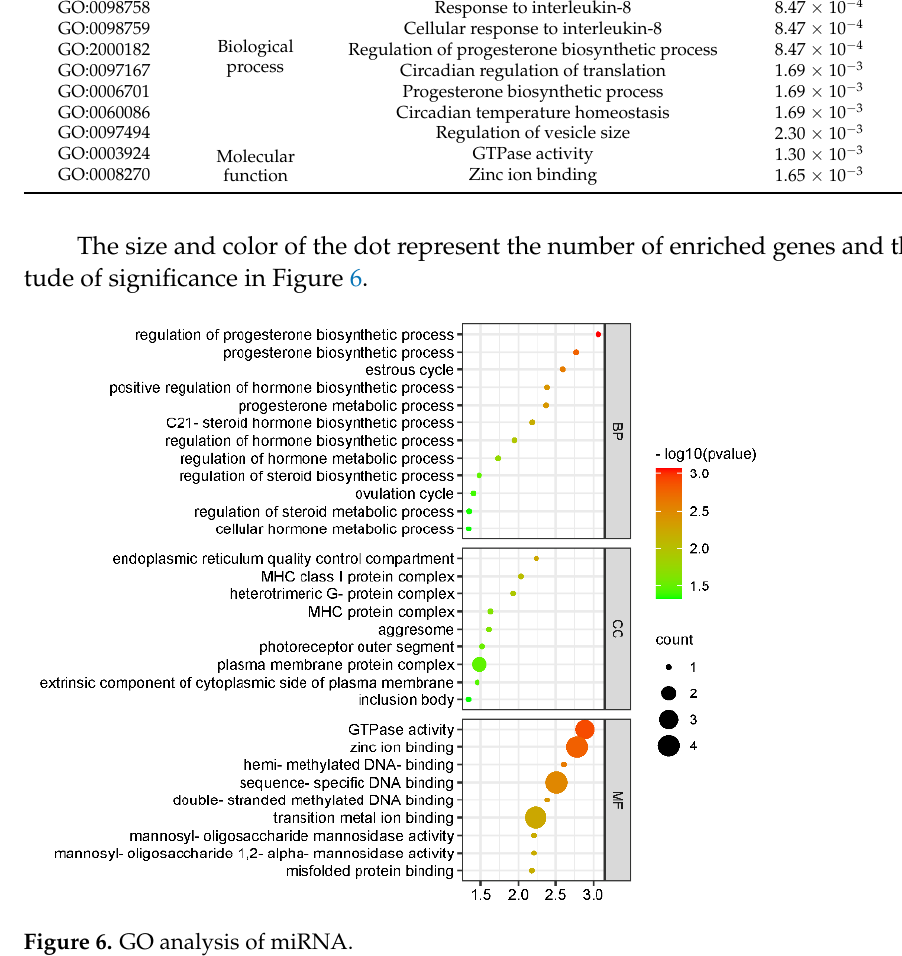
Figure 7. KEGG enrichment pathway of significantly different genes . Different column heights represent the magnitude of enrichment significance of this pathway.